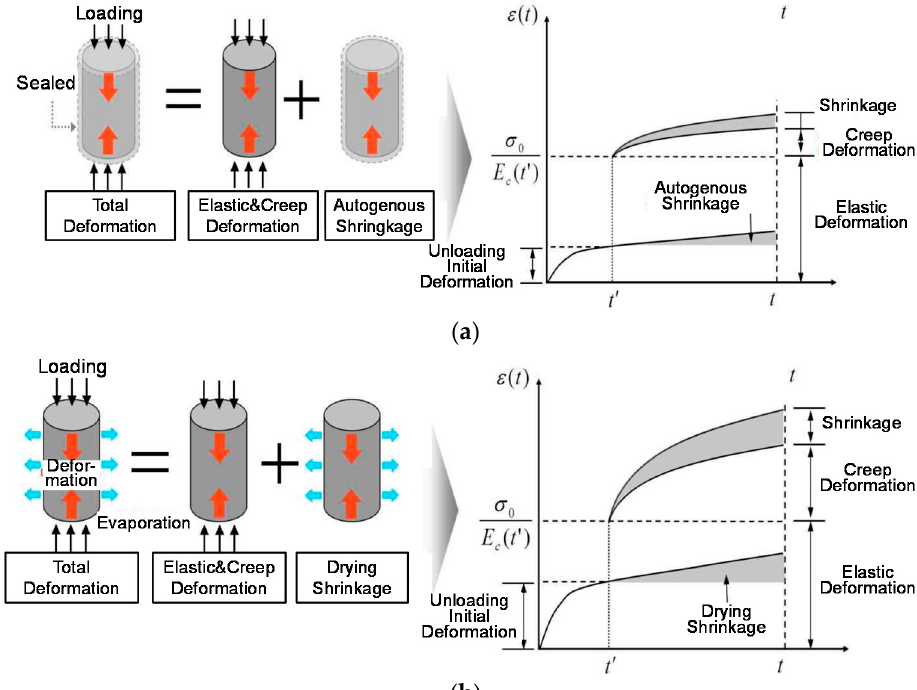
Figure 1. Creep deformation with curing conditions: ( a ) sealed (basic creep); ( b ) unsealed (drying